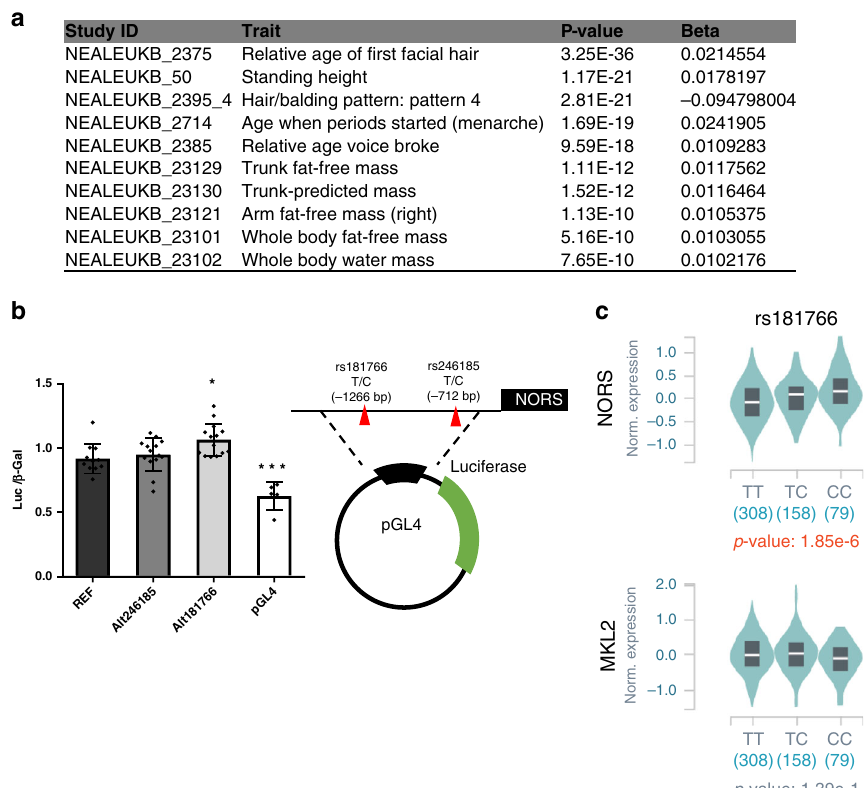
Fig. 8 The impact of rs181766 on lincNORS promoter activity. a List of physical traits that are reported as signi fi cantly associated with rs181766 in UK Biobank (https://genetics.opentargets.org/). b The effect of two selected SNPs rs246185, rs181766 on lincNORS expression was examined using luciferase assay. A diagram displaying the lincNORS promoter cloning was shown on the right. Data represent mean + SD from 4 to 11 biological replicates (* p < 0.05, *** p < 0.005, one-way ANOVA followed by Dunnett ’ s multiple comparisons test against REF). c eQTL boxplot showing genotype-expression relationships between rs181766 and lincNORS (top) or the closest protein-coding gene MKL2